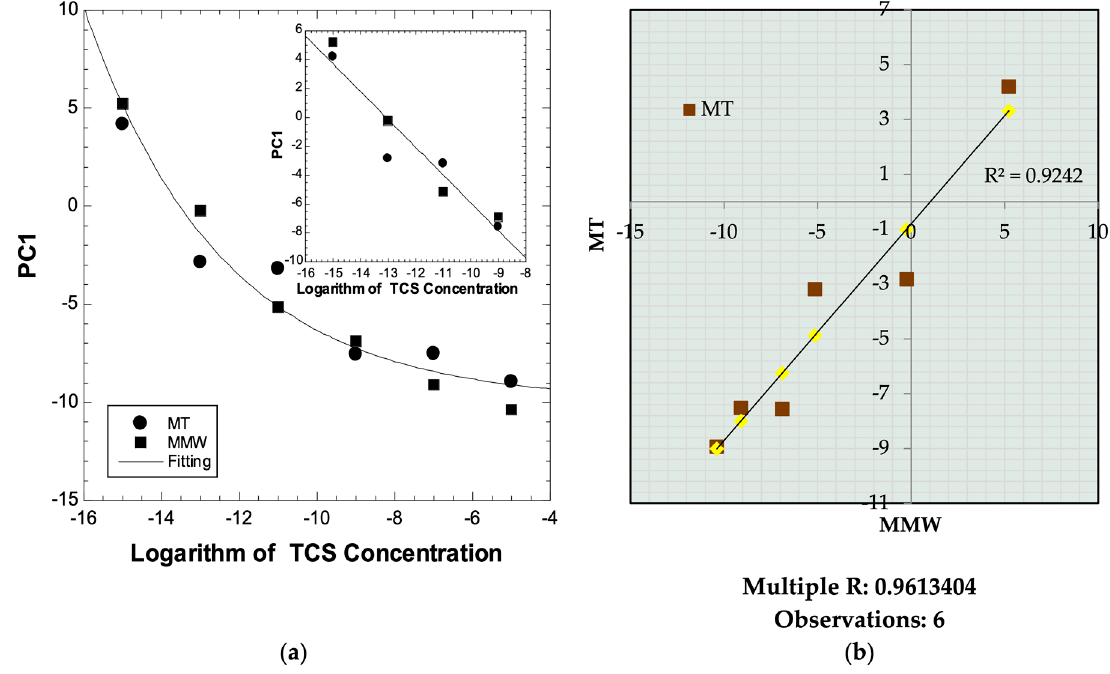
Figure 5. ( a ) Principal components PC1 factor scores versus TCS concentrations for MT and MMW e-tongue (data from Figure 4); ( b ) PC1 distributions of MT and MMW e-tongue. Prediction data (adjusted with the MT data) are in yellow. A linear fit to the data is shown as a black